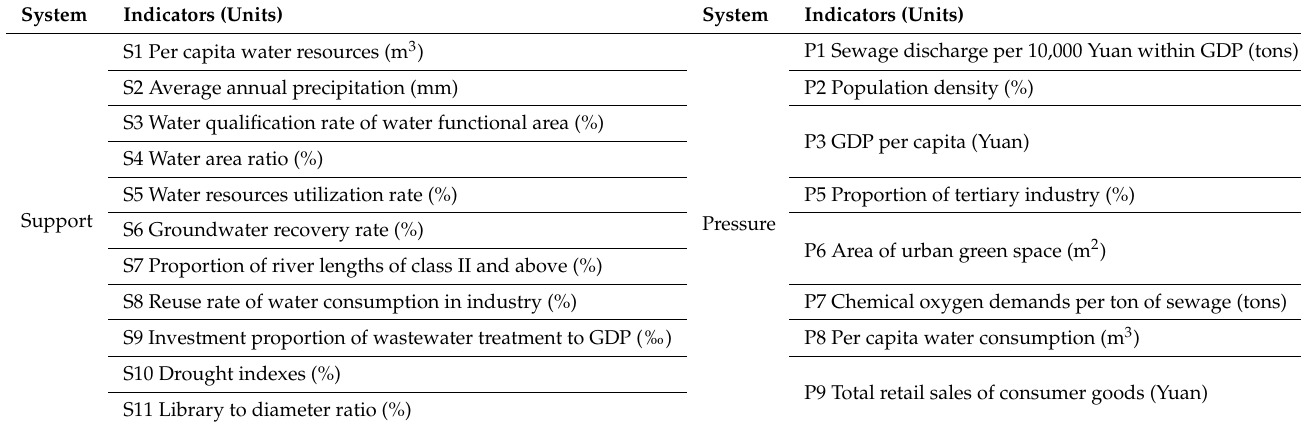
Table 1. The proposed indicators of the carrying capacity of water resources and the